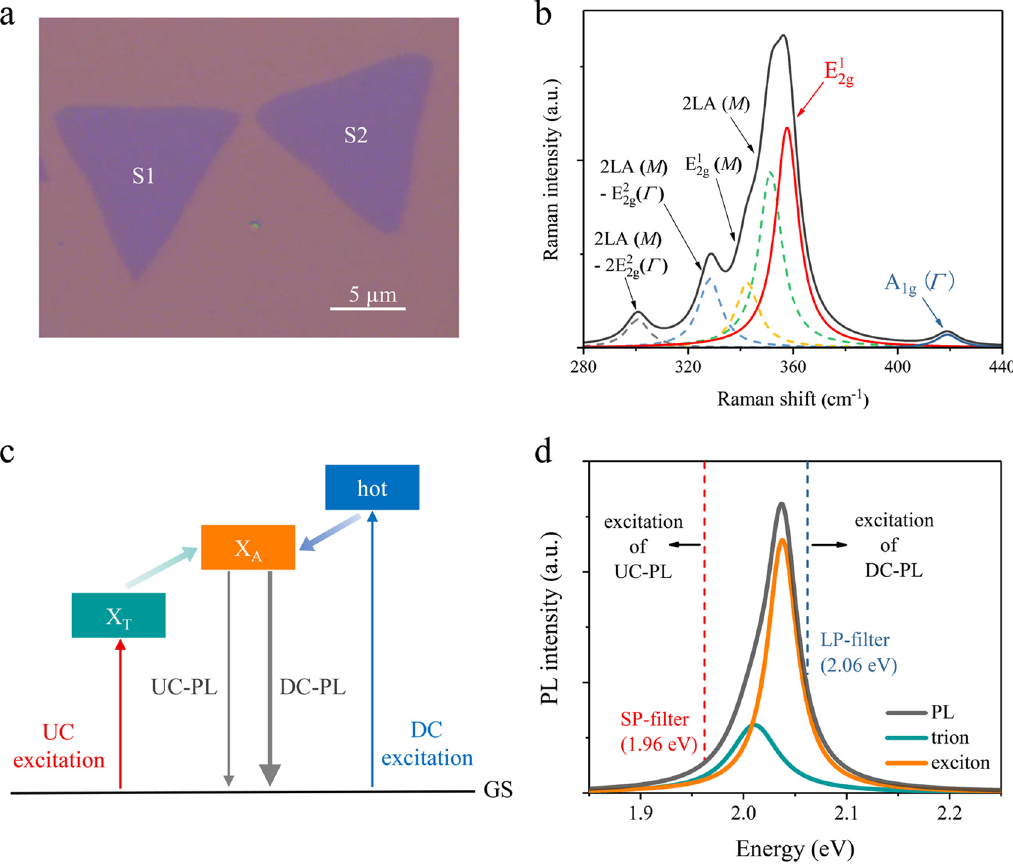
Figure 1: Downconversion (DC) and upconversion (UC) processes in monolayer WS 2 . (a) Optical image of monolayer WS 2 on Si/SiO 2 substrate. (b) Raman spectrum of monolayer WS 2 . (c) The schematic of DC and UC processes. GSisthegroundstate.X T ,X A andhotrepresentthetrions,A-excitonsandhotcarriers,respectively.Redandbluelinesrepresenttheexcitation process by off-resonance energy. Gray lines indicate the emission of A-excitons through DC and UC processes. (d) The PL spectrum of monolayer WS 2 excited by 512-nm continuous-wave laser at room temperature. The dash lines show the fi lter